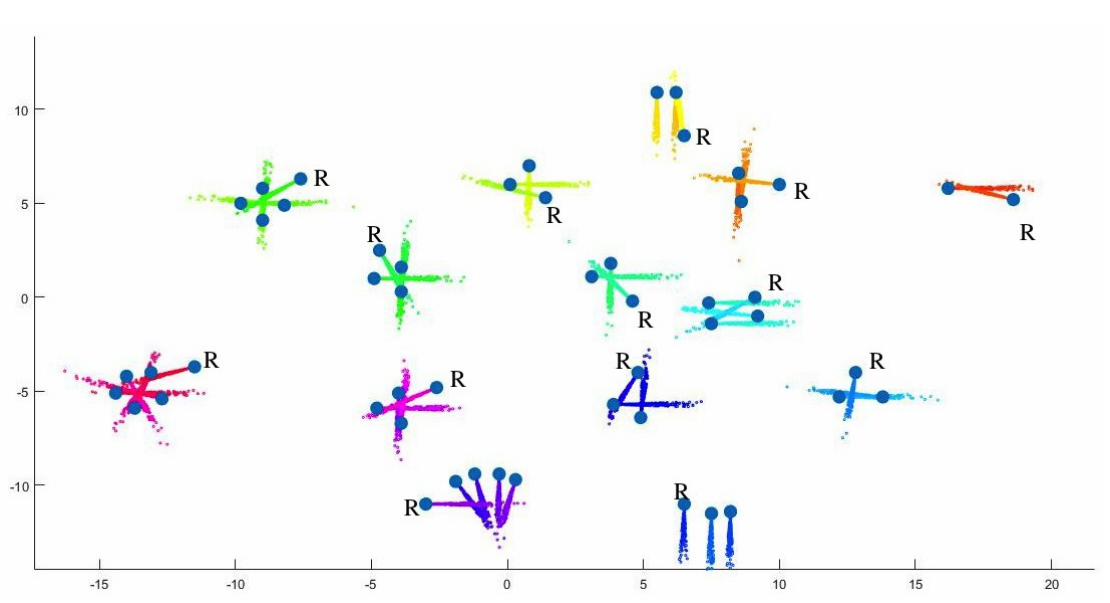
Figure 11. Analysis of F-formations using Vascon’s method [23]. The image depicts the VAs and the robot in the scene. The data are taken from one of the subjects. In our model, the parameter values of l = 20, aperture = 160, and Gaussian samples = 2000 were used for F-formation analysis, and l = 2, aperture = 60 and Gaussian samples = 200 were used for the